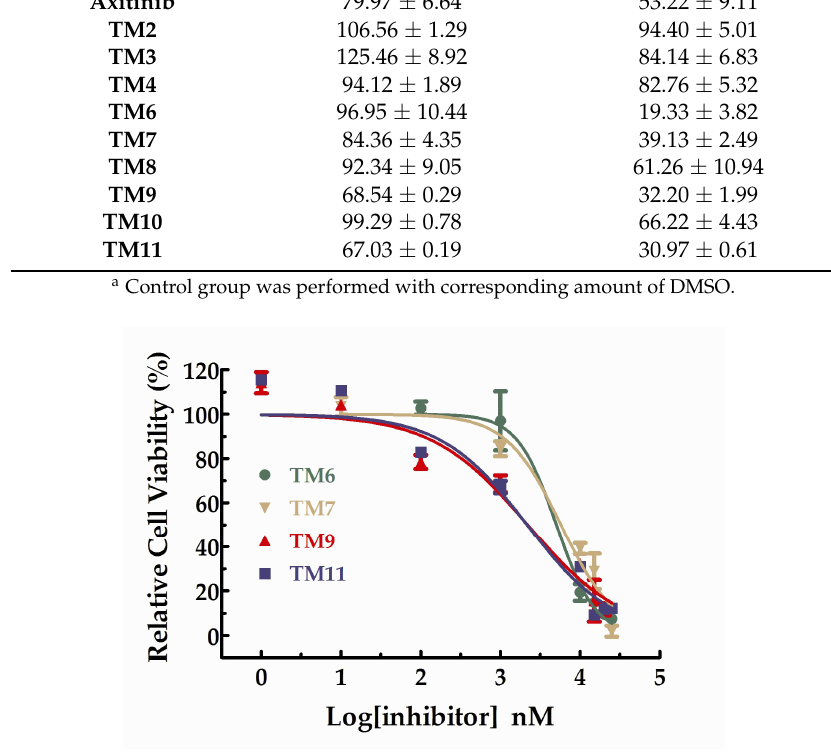
Figure 4. Dose–response curves for the relative cell viability of HUVEC in the presence of TM6 , 7 , 9 and 11 .